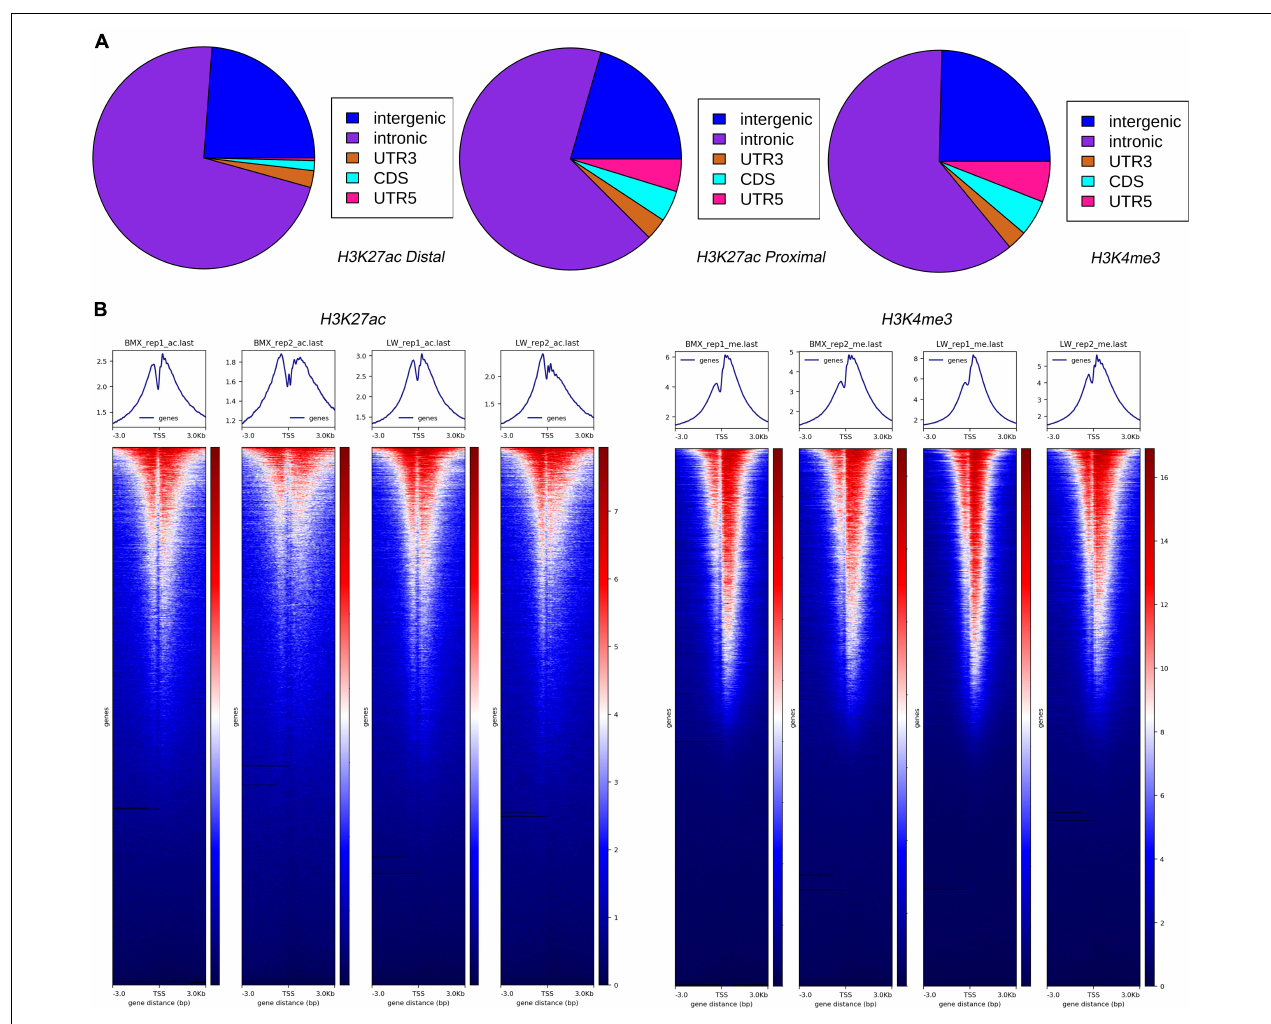
FIGURE 2 | Enrichment of H3K4me3 and H3K27ac peaks across genomic features and transcription start sites. (A) Distribution of H3K4me3 and H3K27ac peaks across genome. (B) Heatmaps depicting normalized ChIP-seq signal (H3K27ac and H3K4me3) at 3 kb near the TSS, sorted by signal intensity.